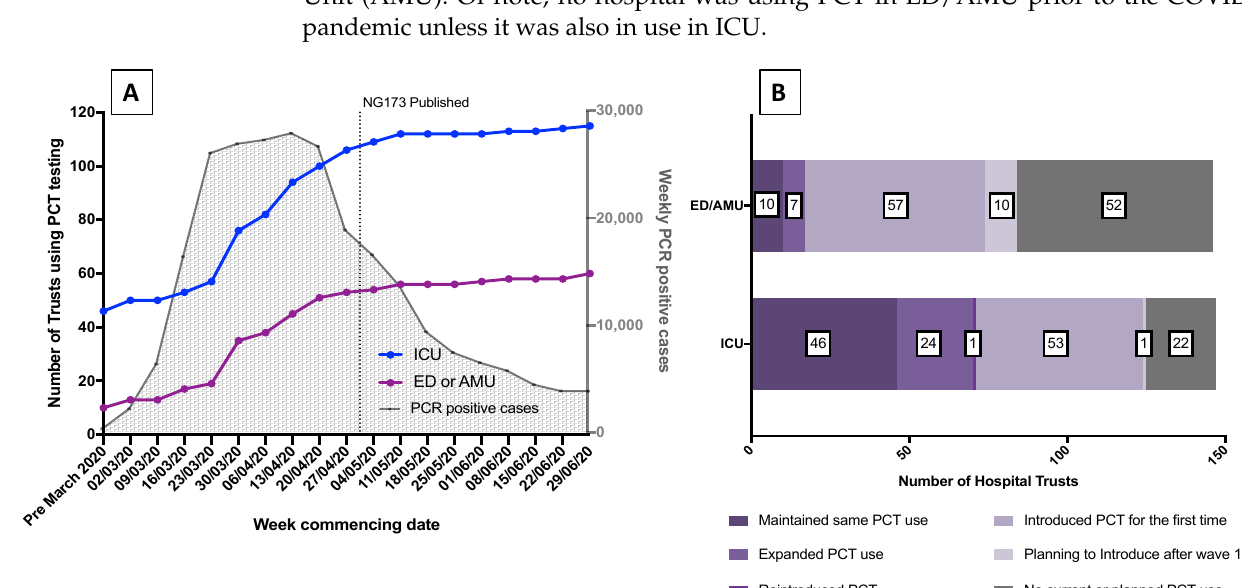
Figure 1. Changed use of PCT testing at acute NHS hospitals in England and Wales. ( A ) Weekly number of hospi- tals using procalcitonin (PCT) on intensive care unit (ICU) (- • -) and Emergency Department (ED)/Acute Medical Unit (AMU) (- • -). For reference, the time course of the COVID-19 pandemic first wave in England is shown as weekly num- ber of PCR positive cases (-). NG173 = National Institute for Health and Care Excellence (NICE) COVID-19 rapid guideline NG173: [9] Data extracted from Public Health England (PHE) national COVID surveillance reports avail- able at: